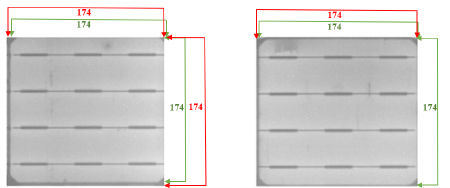
Figure 13. Errors in cell segmentation, where the green and red labels correspond to the true and the extracted cell boundaries,